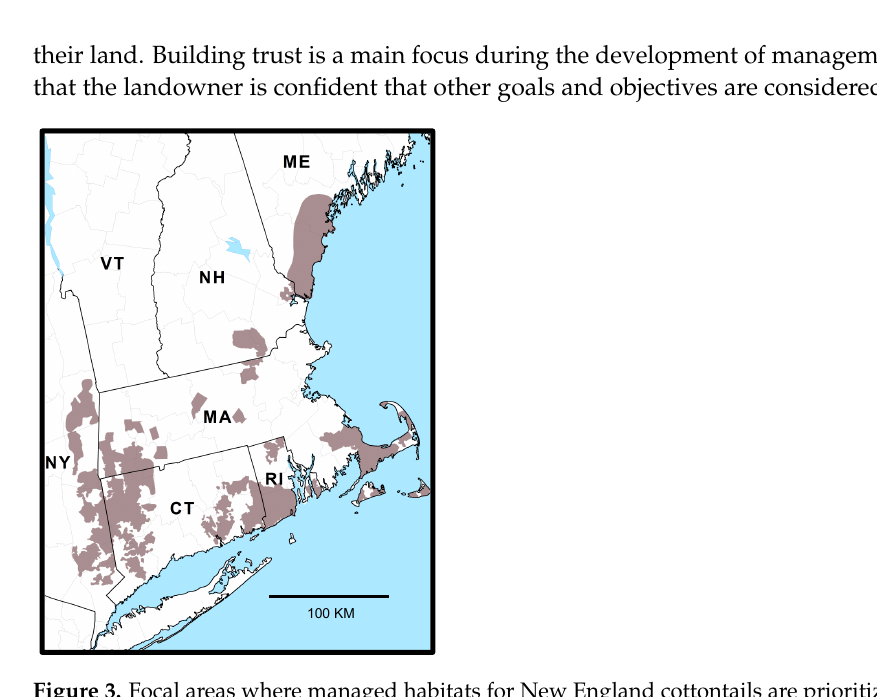
Figure 3. Focal areas where managed habitats for New England cottontails are prioritized within the species’ historic range [34].